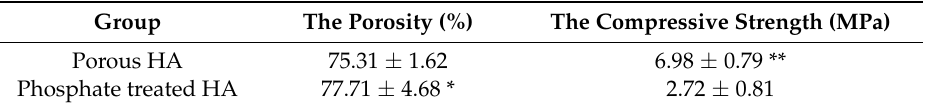
Table 1. Characteristic properties.